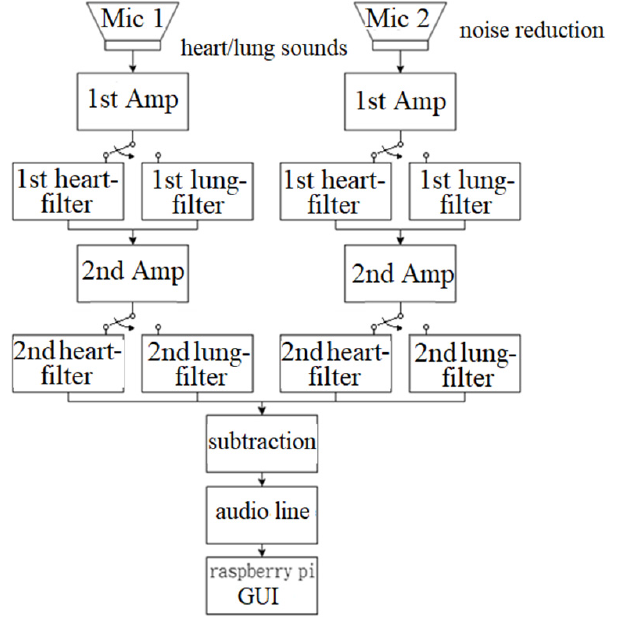
Figure 1. System architecture of electronic stethoscope.